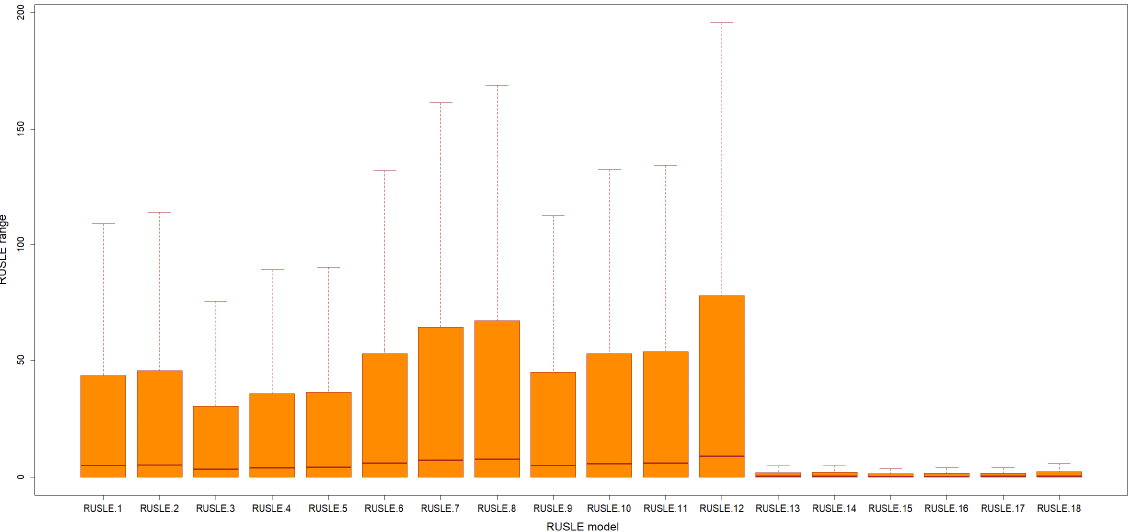
Figure 10. Boxplot shows the distributions of the ~5% random selected pixels from the 18 RUSLE scenarios used in this study (outlier pixels were removed).